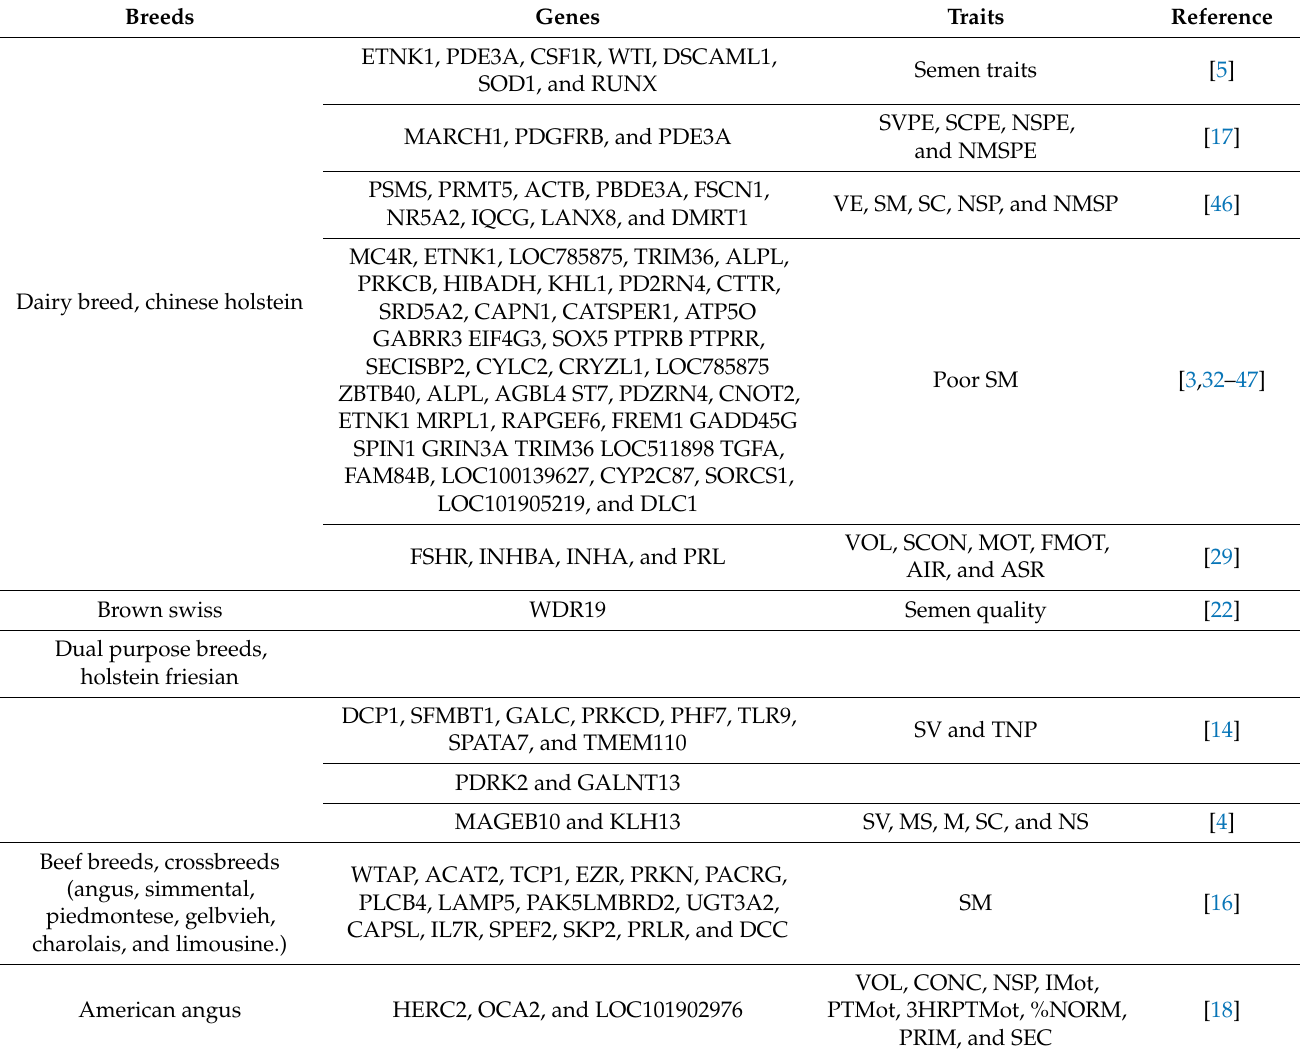
Table 4. Breeds, genes, and traits of